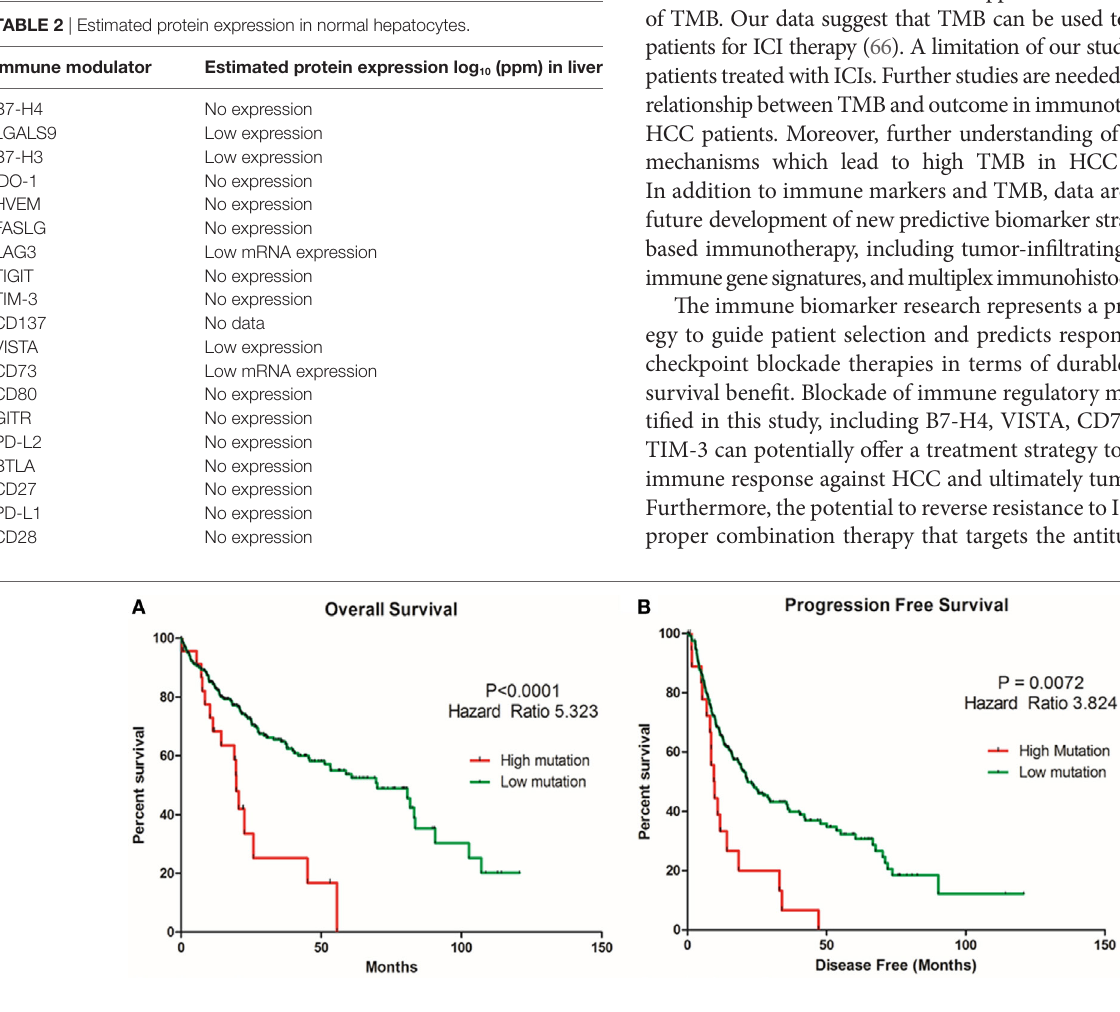
FigUre 13 | Relationship of tumor mutational burden (TMB) and overall and progression-free survival in HCC patients. Kaplan–Meier curves produced using the cBioportal for the analysis of (a) overall survival and (B) progression-free survival in HCC patient samples. Green curve represents low mutation or TMB, while red curve represents high mutation or TMB. The study time (months) is presented on the x -axis.